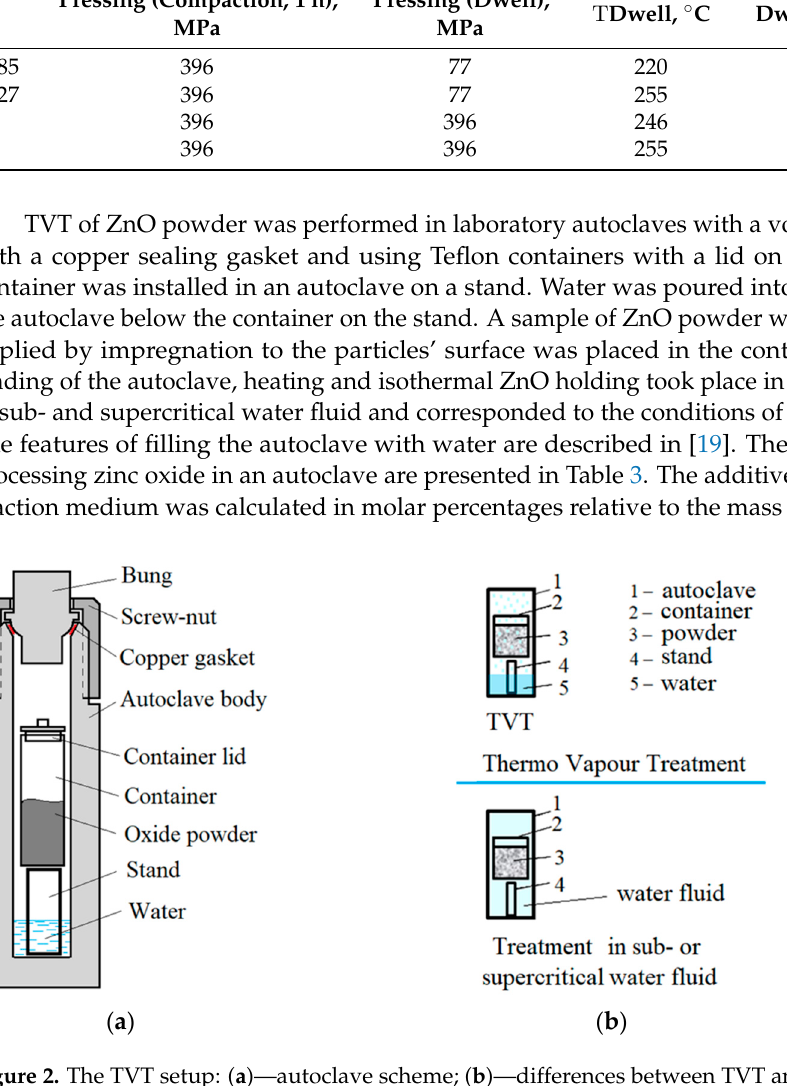
Figure 2. The TVT setup: ( a )—autoclave scheme; ( b )—differences between TVT and sub- or super- critical water fluid treatment. Table 3. The TVT